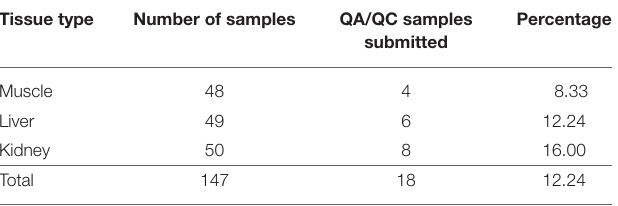
TABLE 1 | Quality assurance and quality control sample